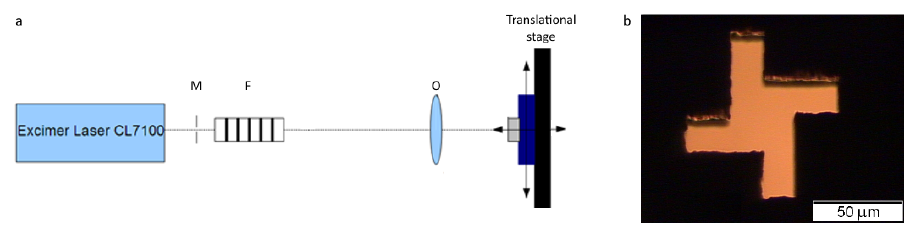
Figure 1. ( a ) Schematic of the projection optical setup used for sample irradiation; ( b ) the mask image obtained using an optical